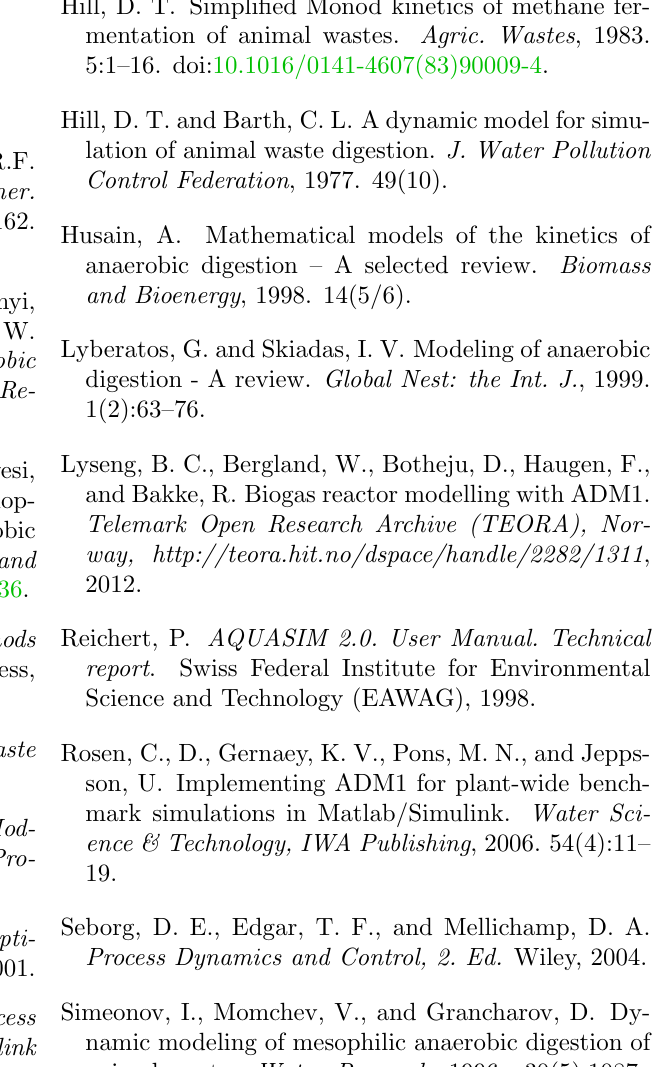
Table 12: Values of inputs and states in one example of a steady-state operation point. F feed = 45 L/d T reac = 35 o C S vs = 30 . 2 g/L in S bvs = 5 . 2155 g/L S vfa = 1 . 0094 g/L X acid = 1 . 3128 g/L X meth = 0 . 3635 g/L F meth = 196 . 1560 L CH 4